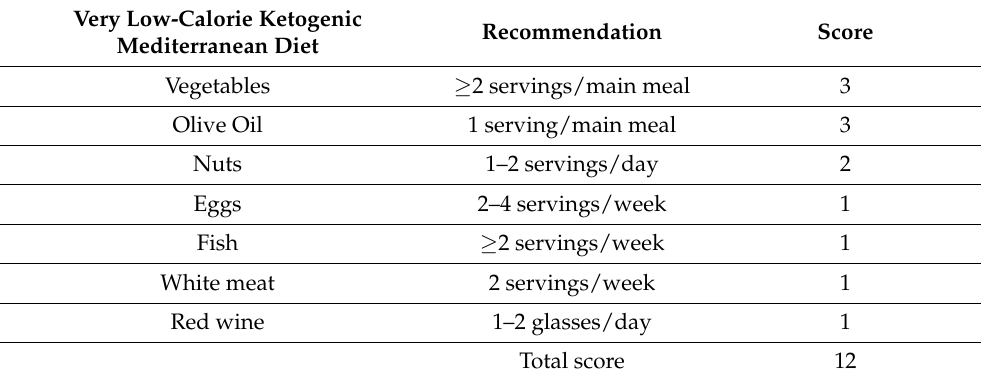
Table 4. VLCKD_MED: the Mediterranean Diet Serving Score. Very Low-Calorie